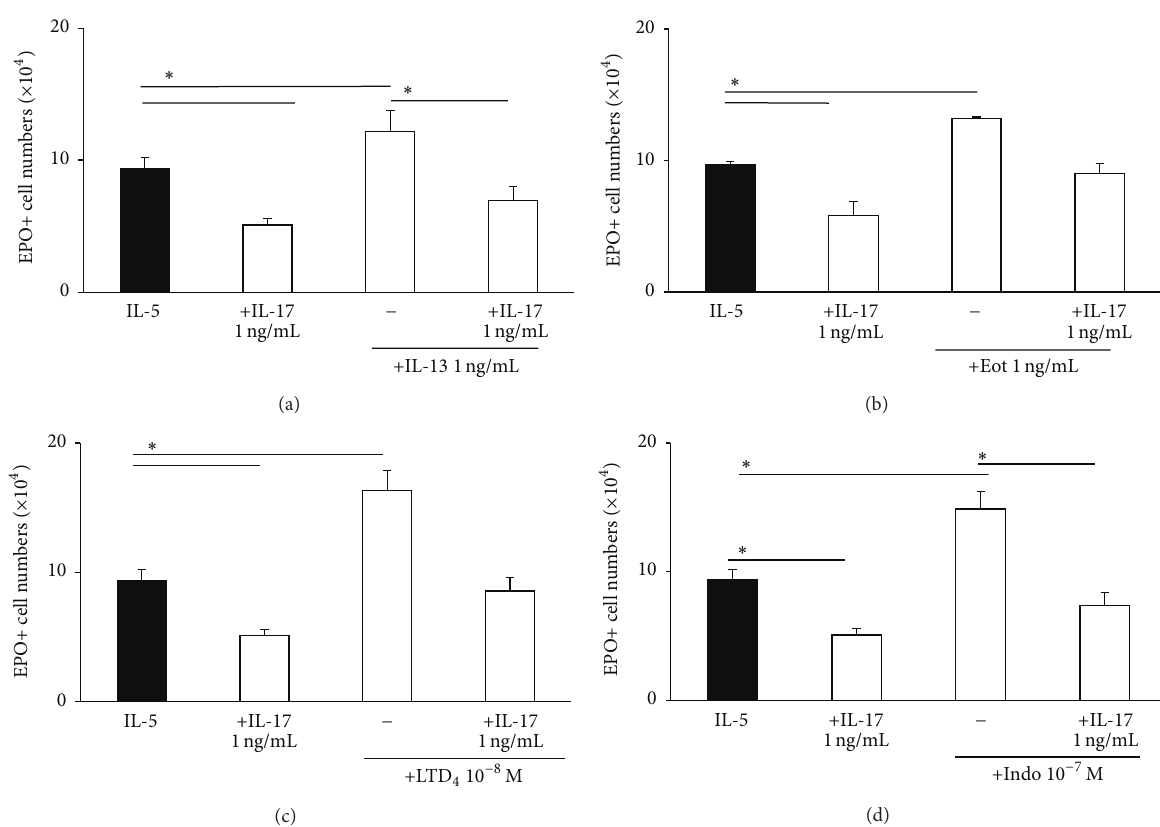
Figure 4: Blockade of IL-17 effects by agents which signal through CysLT1R. Liquid bone-marrow cultures were established from BALB/c mice as detailed in Figure 1. Different agonists which share the ability to signal through CysLT type 1 receptors (CysLT1R) were added to the cultures, alone or in association with IL-17A. These include (a) IL-13 and (b) eotaxin (Eot) [36] and (c) leukotriene D 4 (LTD 4 ) and (d) indomethacin [34]. ∗ 𝑃 < 0 . 05 for the indicated differences. Data are mean ± SEM ( 𝑛 = 3).